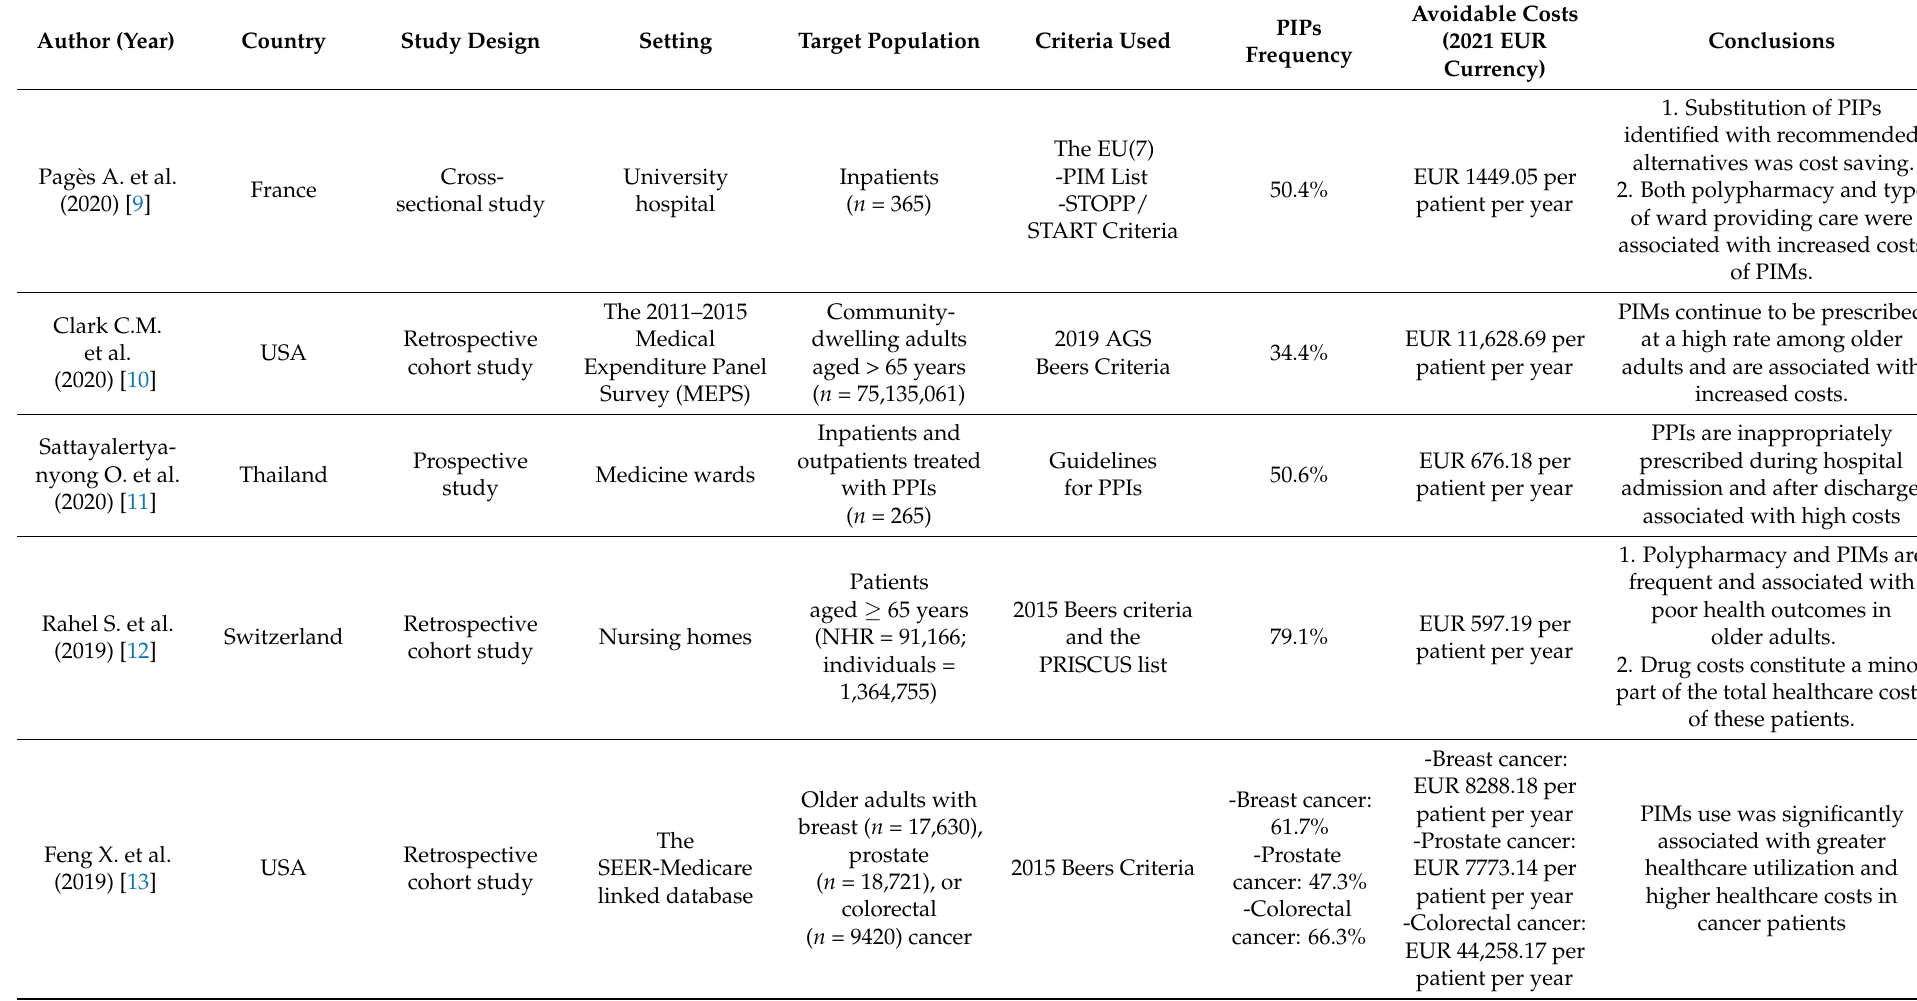
Table 3. Characteristics of included descriptive studies without